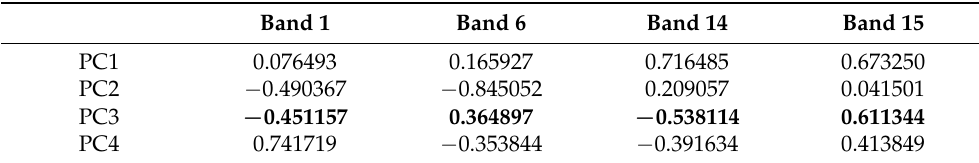
Figure 3. Spectral curves of sericite, chlorite, and epidote from visible to shortwave infrared spectra in WV-3 data (the spectral curves from the USGS spectral library version 7). Table 3. Eigenvector matrix of the sericite obtained via the PCA method. Table 3. Eigenvector matrix of the sericite obtained via the PCA method.